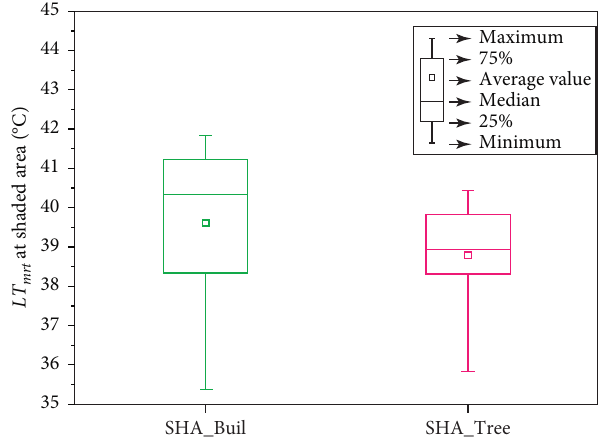
Figure 10: Long-wave mean radiant temperature at the two shaded areas.